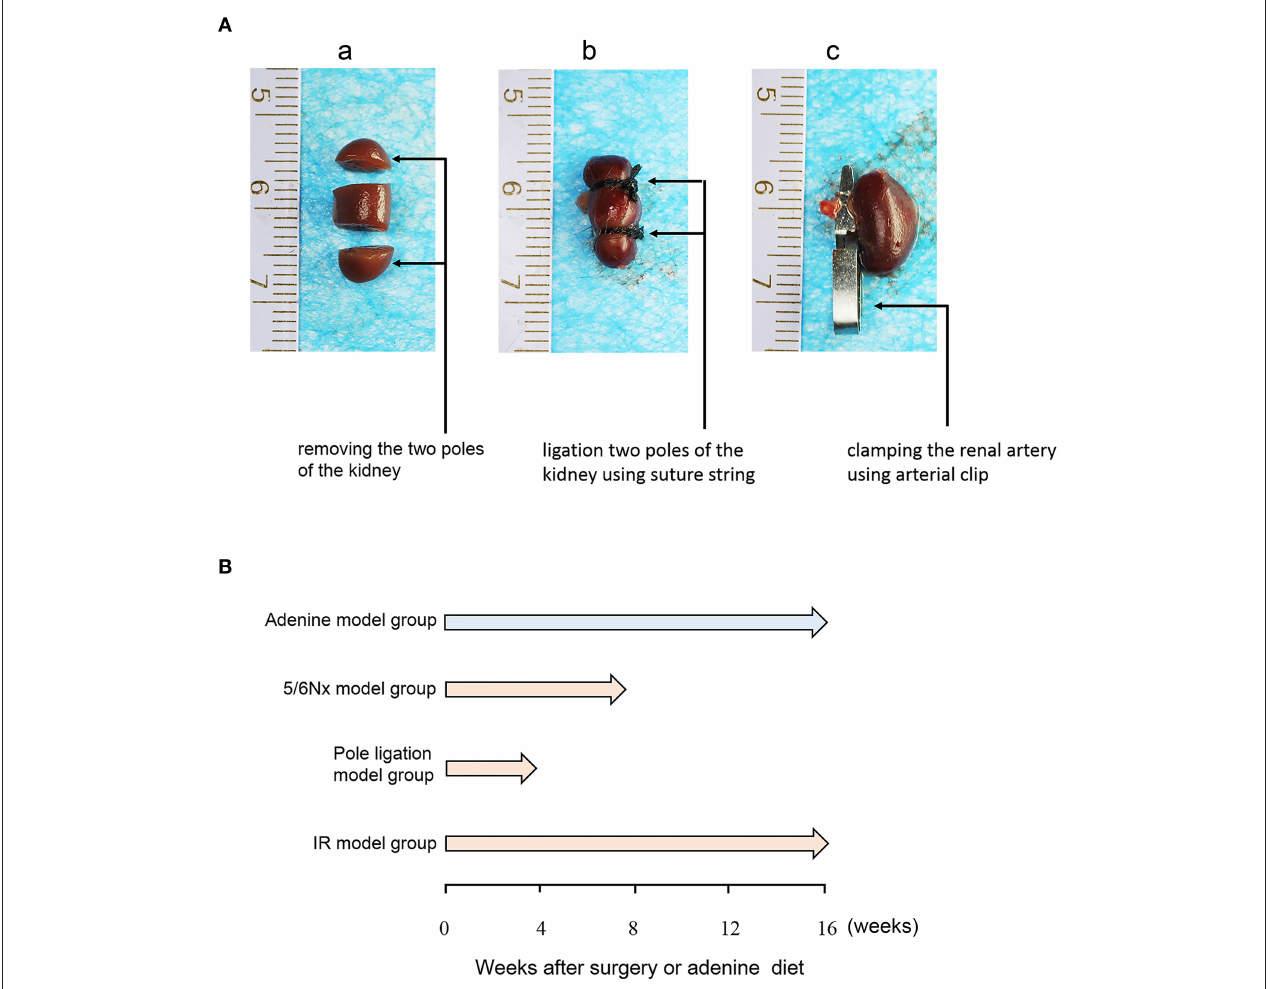
FIGURE 1 | Protocols for the induction of UCM. (A) Diagrammatic drawing of surgery of the 5/6 nephrectomy group (5/6Nx), pole ligation group, and uninephrectomy plus contralateral ischemia followed by reperfusion group (IR). (B) Eight-week-old C57BL/6J male mice were randomly allocated to the sham ( n = 14), 5/6th nephrectomy group (5/6Nx) ( n = 45), pole ligation group ( n = 34), uninephrectomy plus contralateral ischemia followed by reperfusion group (IR) ( n = 20), and adenine group ( n = 15). Mice were killed at 4, 8, and 16 weeks after surgery in the pole ligation, 5/6th nephrectomy, and uninephrectomy plus contralateral ischemia followed by reperfusion (IR) groups, respectively. In the adenine group, mice were killed at 16 weeks after the adenine diet